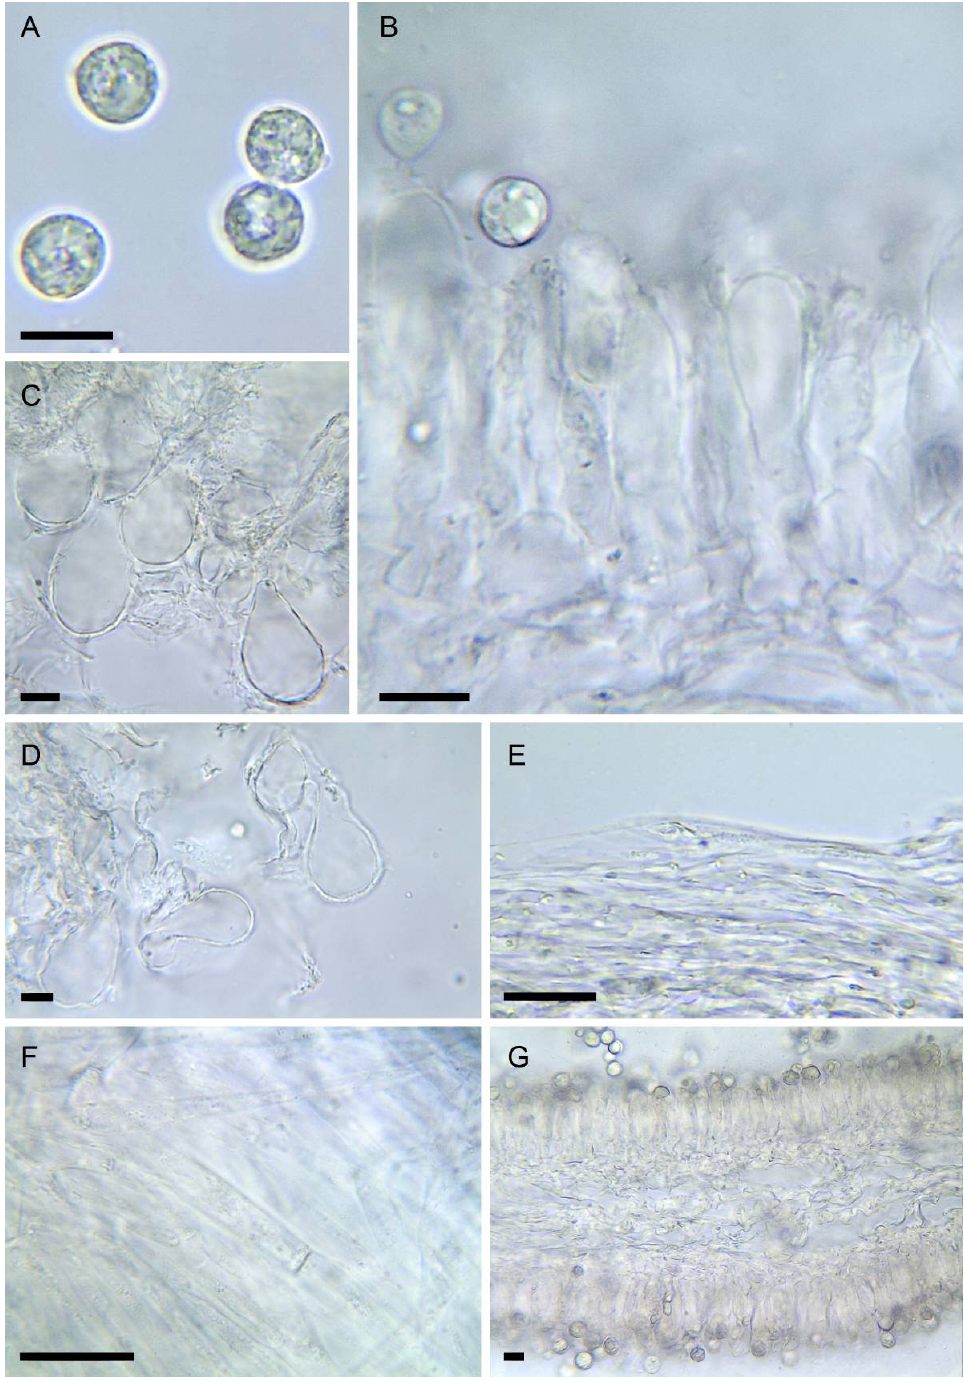
Figure 5. Amanita amerivirosa (LIP:0401671). ( A ) Basidiospores. ( B ) Hymenium and subhymenium. ( C ) Lamella edge with terminal cells. ( D ) Elements of partial veil (upper surface). ( E ) Elements of suprapellis. ( F ) Pileipellis, radial section. ( G ) Hymenophore, longitudinal section. All observations in 5% KOH solution. Bar = 10 μm.